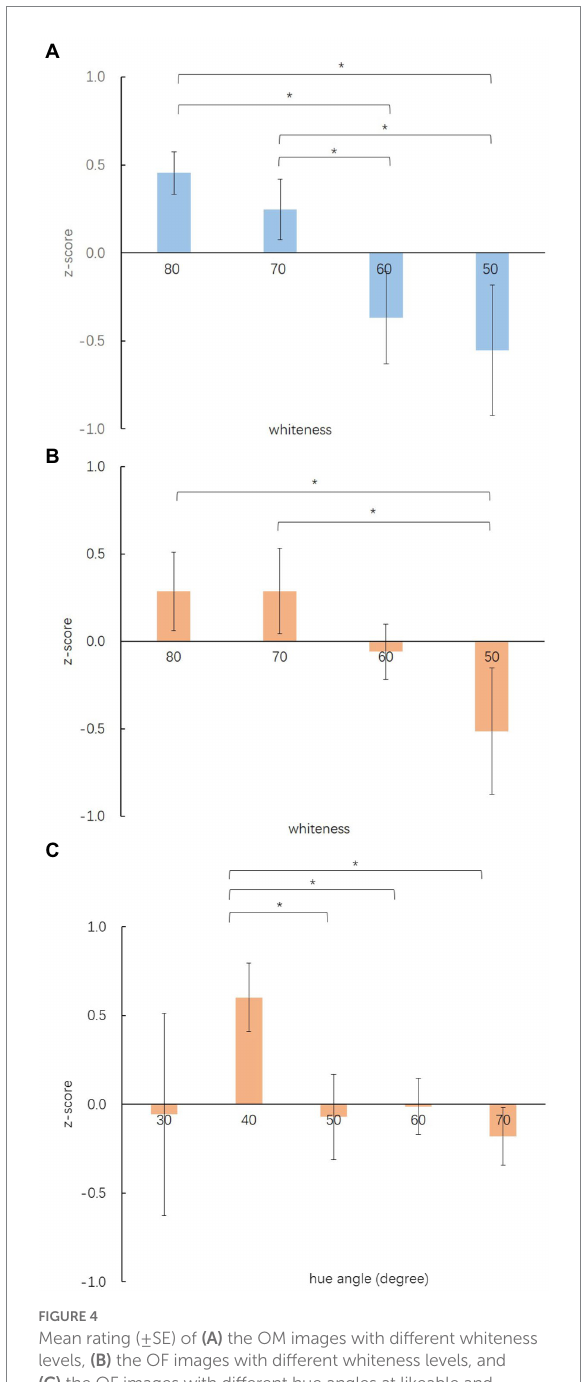
FIGURE 4 Mean rating (±SE) of (A) the OM images with different whiteness levels, (B) the OF images with different whiteness levels, and (C) the OF images with different hue angles at likeable and dislikeable. Asterisks indicate statistical significance at * p < 0.05 (Games-Howell